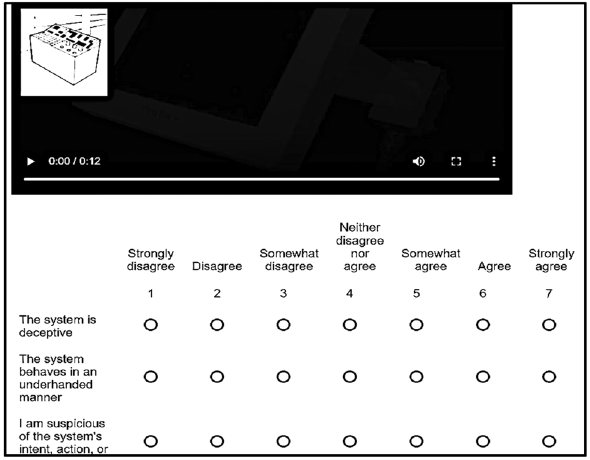
Figure 2: Snapshot of scenario video clip with Likert